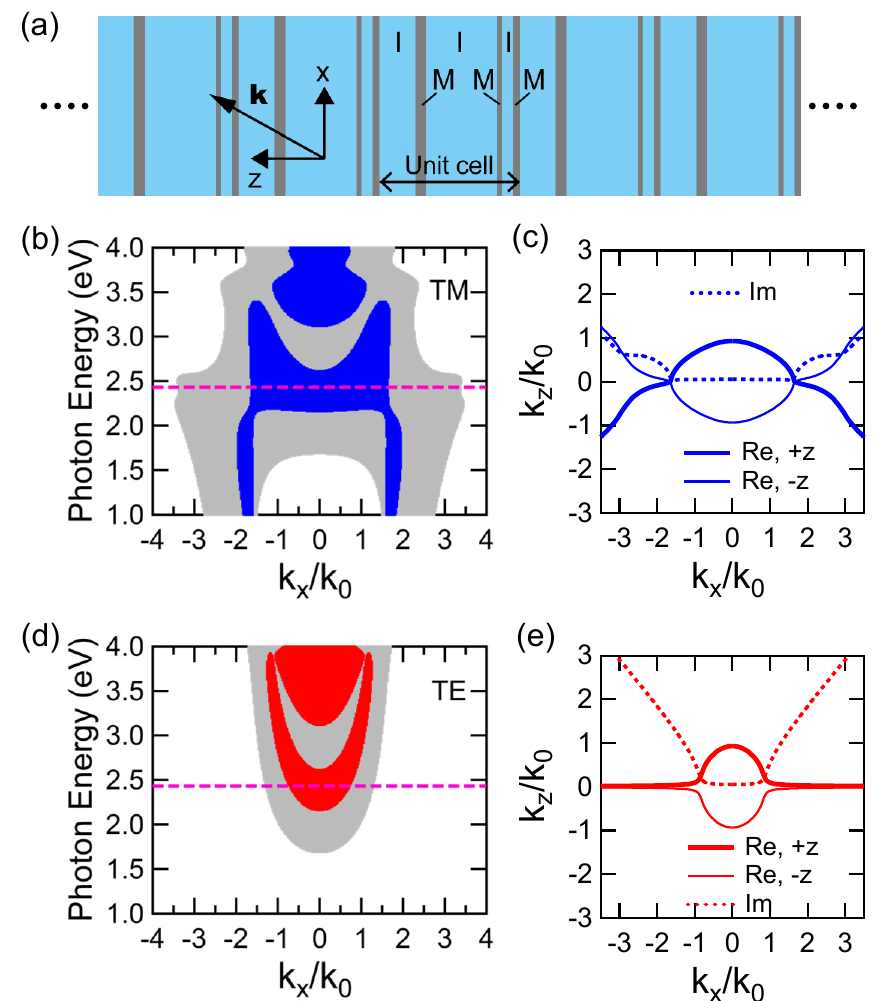
Figure 3. ( a ) Schematic of a SMIM of the six-layer unit cell that has a transmission window at 500 nm. The structural parameters are described in the text. ( b ) Transverse magnetic (TM)-polarization Bloch band, shown in a similar manner to Figure 2d. ( c ) Equi-frequency TM contour at 2.4304 eV (or 510.0 nm). Solid lines denote the real part of k dotted line the imaginary part. ( d ) TE-polarization Bloch band; red denotes the low-loss band and light gray the relatively large-loss band. ( e ) Equi-frequency TE contour at 510.0 nm, represented similarly to